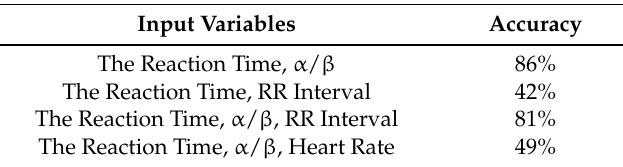
Table 5. Analysis of changing input variables.